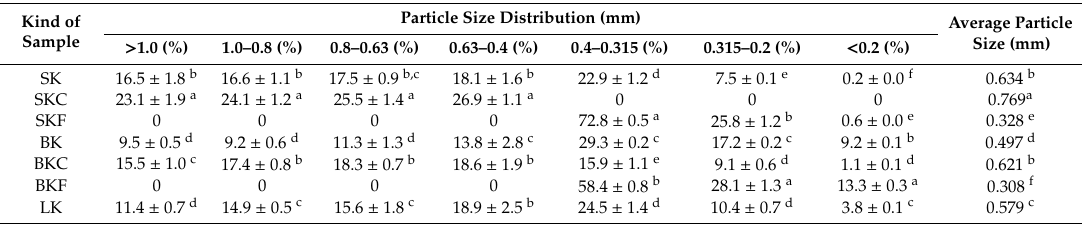
Table 1. Particle size distribution of ground flax